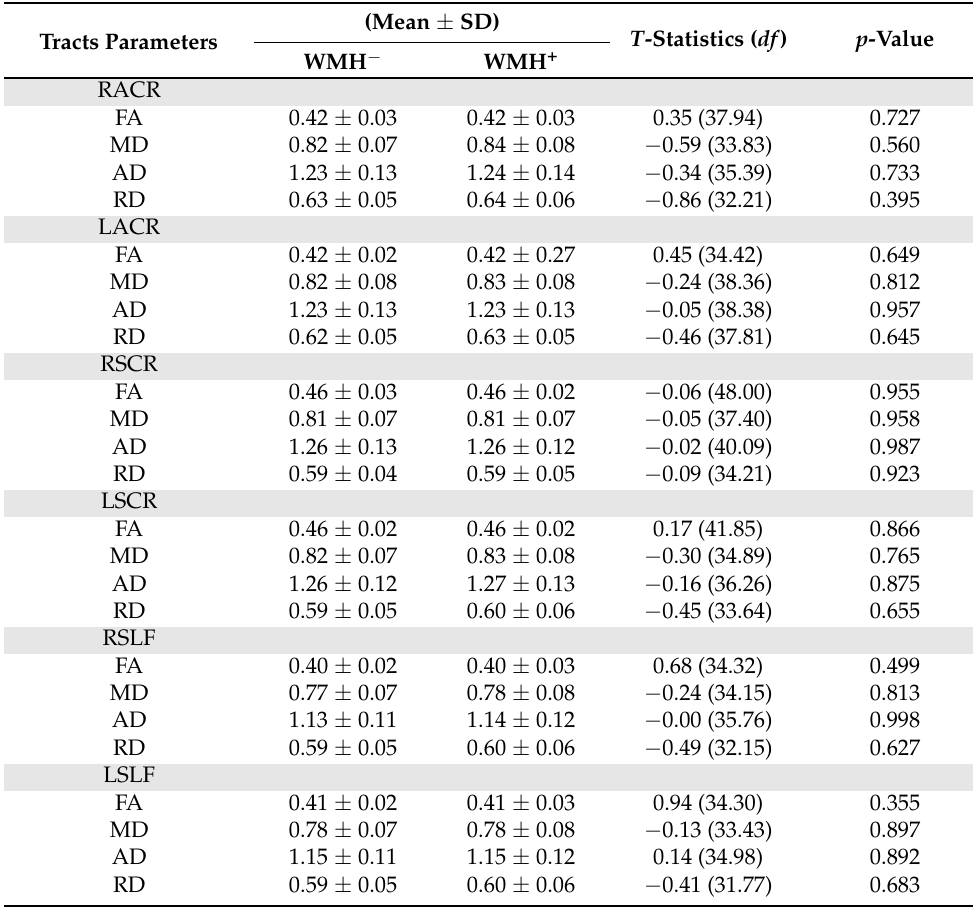
Table 4. Comparison of the integrity of selected white matter between WMH + and WMH - subjects with independent T -tests. Tracts